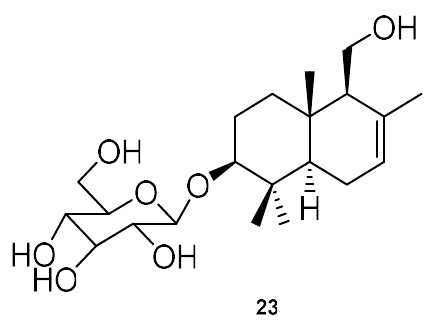
Figure 6. Glycosylated drimane 23 from seeds of Antairis toxicaria [51].